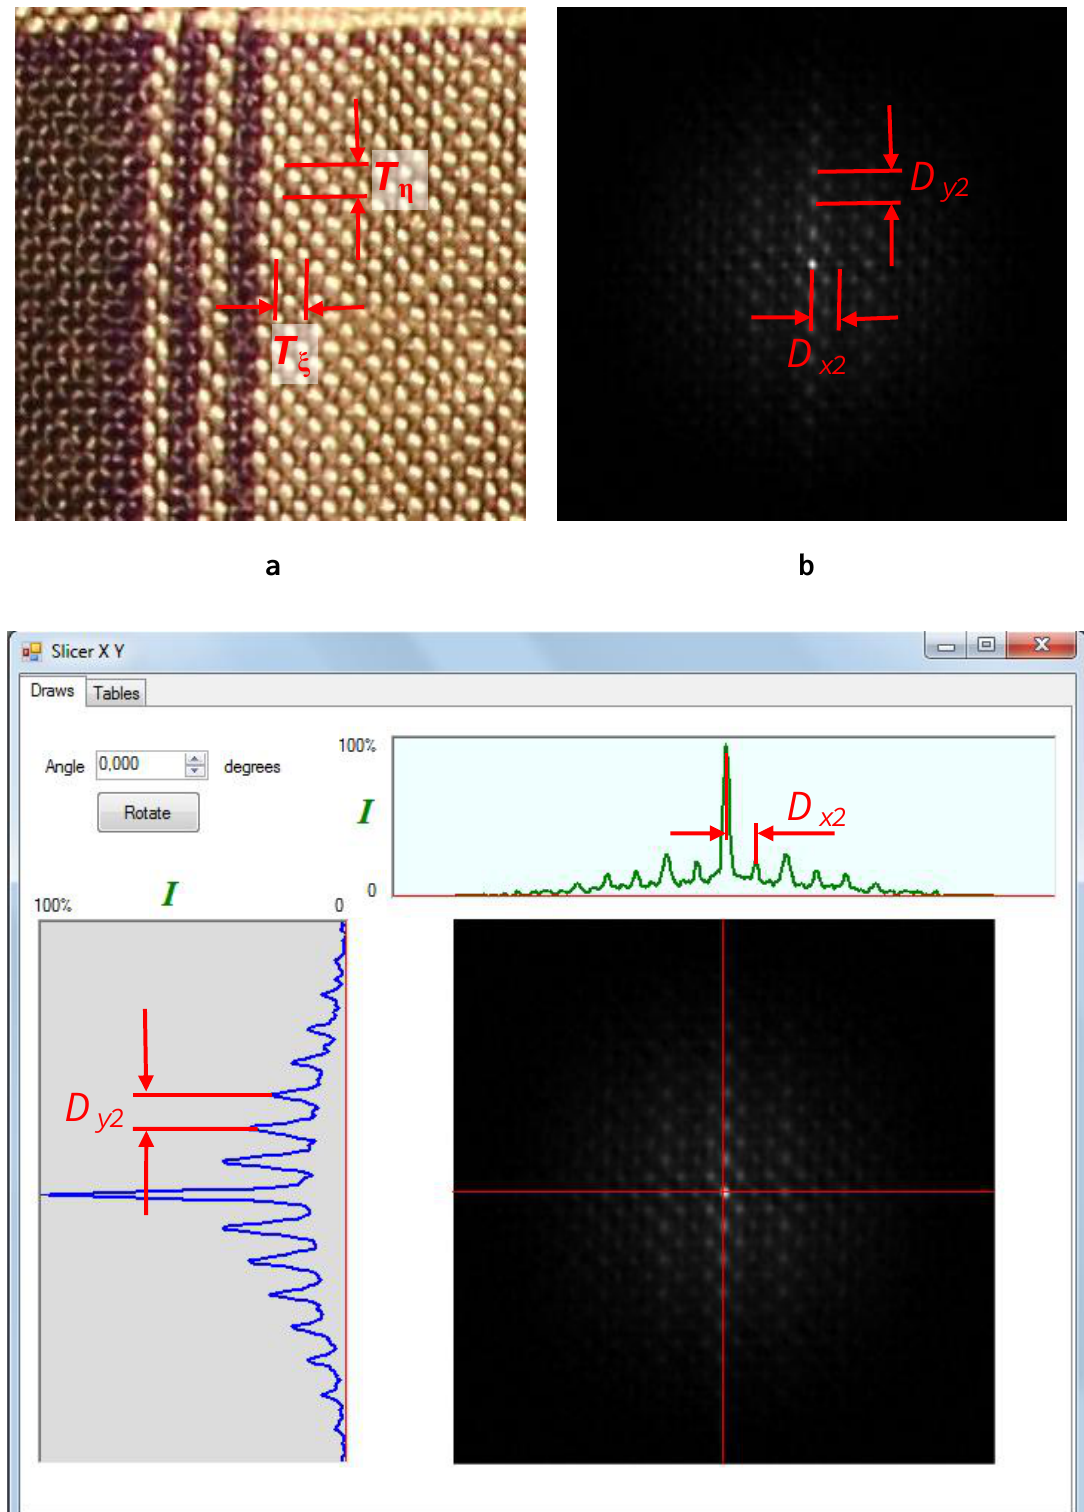
Figure 6. ( a ) The source image of tartan; ( b ) The resulting image after double diffraction pattern calculation using our method; ( c ) Screenshot of the program automatically detecting distances between units in periodical